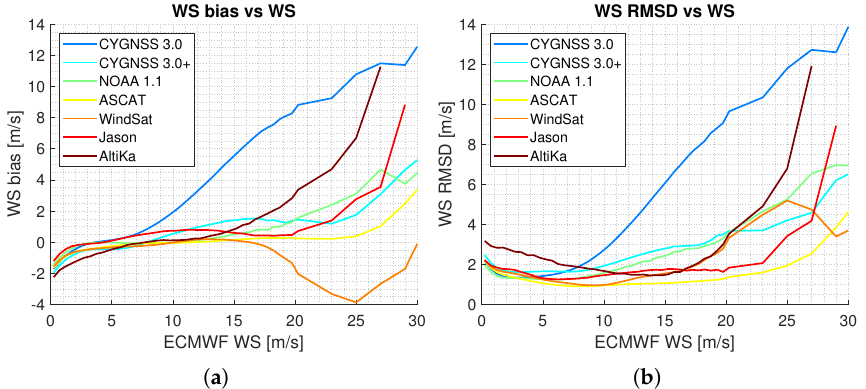
Figure 6. ( a ) Bias and ( b ) RMSD of the wind speed from different products vs the ECMWF wind speed.